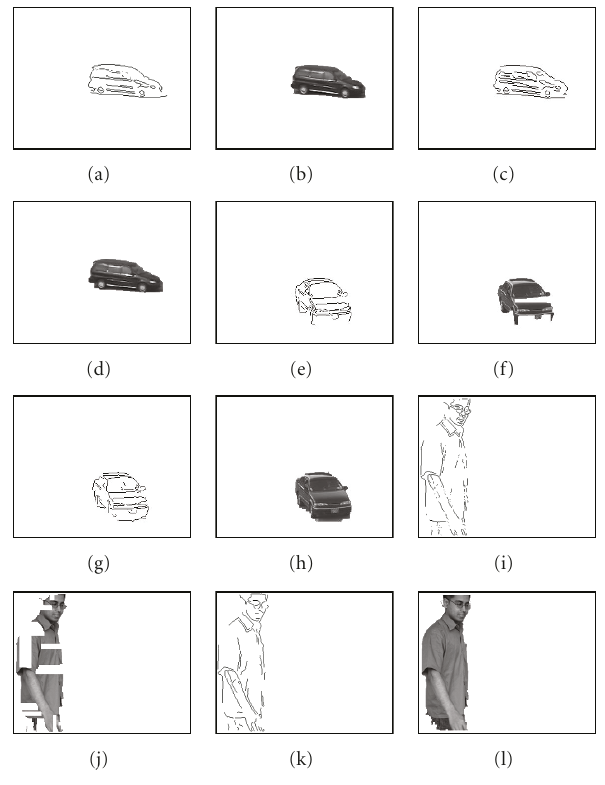
Figure 12: Segmentation of moving object. (a), (e), (i) Moving edge detection results by KW ; (b), (f), (j) segmented moving objects of corresponding edge images by KW ; (c), (g), (k) edge image of detected moving object by the proposed method; (d), (h), (l) segmented moving object of corresponding detected edge image by the proposed method.